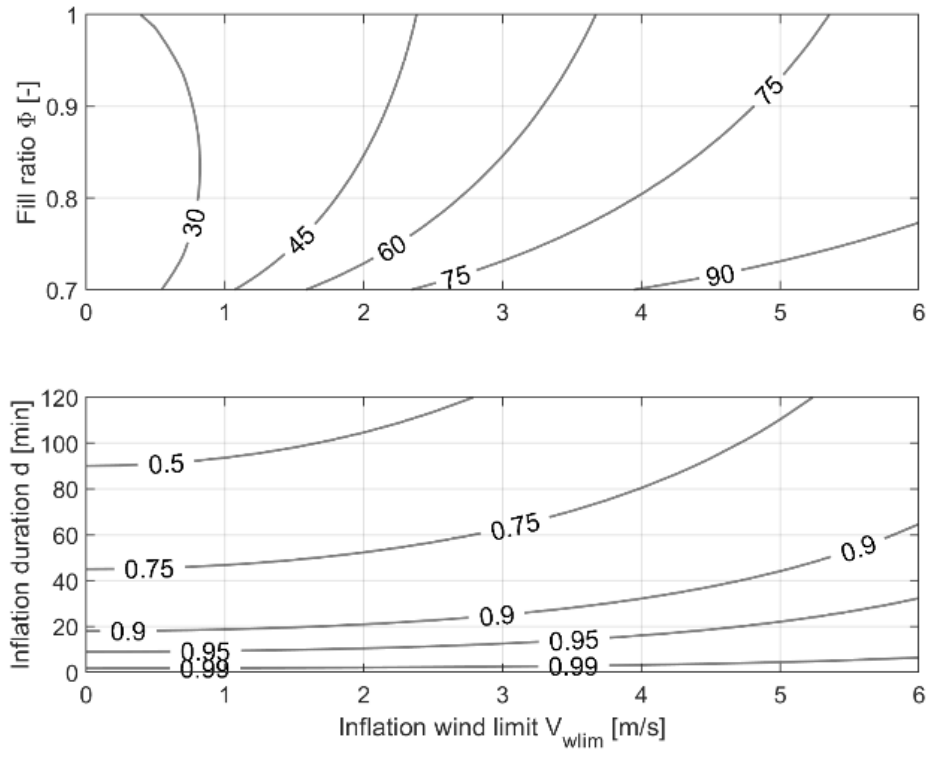
Figure 12. Iso-lines in ( top ) figure represent static blow-down angles as function of lifting gas fill ration and wind speed, ( bottom ) figure represents achievable probabilities to stay below the associated wind speeds and as function of the deployment duration.